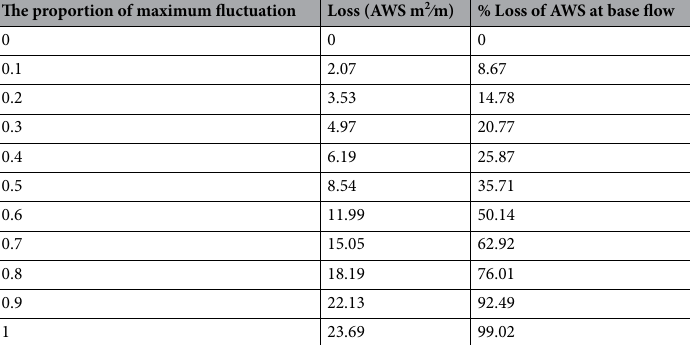
Figure 4. Area weighted suitability (AWS) distribution across dry season (Dec-early dry, Mar-middle dry and May-late dry; Dry season = December–May; Transition season for both dry and wet respectively = November, June; Wet = July–October) and segments (upper, middle and downstream), which shows higher availability of AWS in the confined and unregulated upper segment compared to affected segments from distributaries and human extraction, and seasonally more AWS noticed during the early dry season compared to the middle and late dry season. The line’s median value divides the box and means value represented by a hollow circle. The proportion of maximum